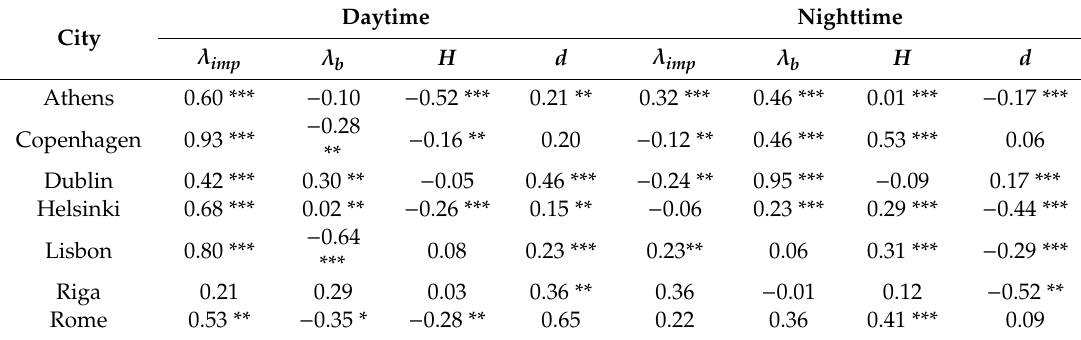
Table 7. Standardized regression coe ffi cients for the multiple regression models between the urban surface parameters, proximity to the sea, and LST for seven coastal urban areas. Daytime Nighttime City λ λ imp b H